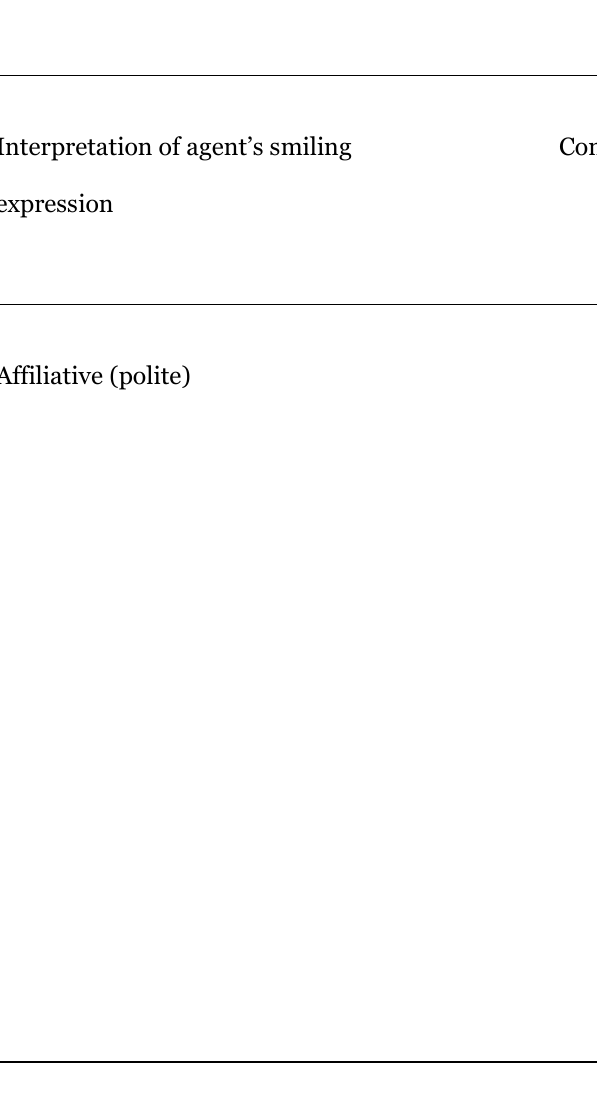
Learners’ Comments Regarding Pedagogical Agent’s Smile